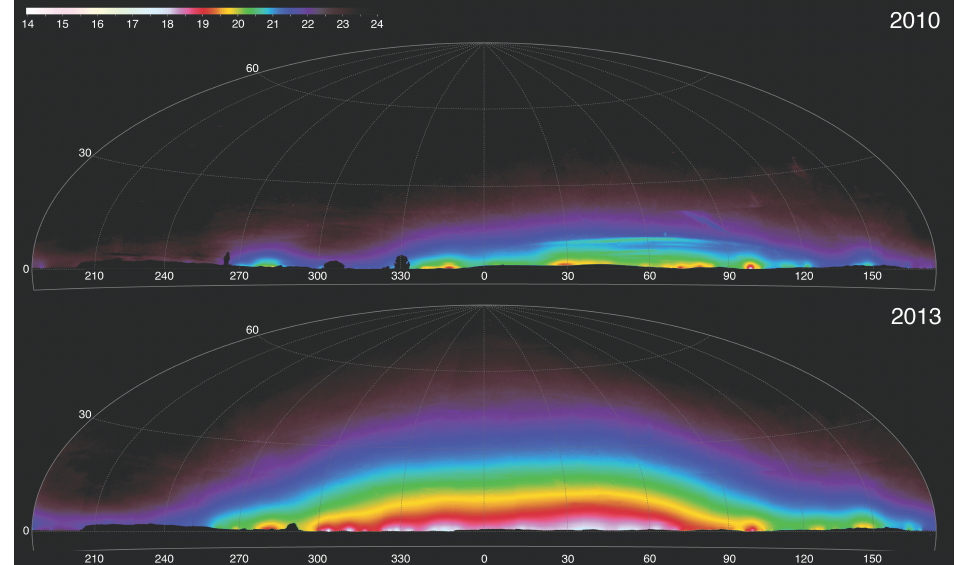
Figure 6. Two views of the modeled anthropogenic component of night sky brightness as seen from Oxbow Overlook in Theodore Roosevelt National Park, U.S., on 1 October 2010 (top) and 9 May 2013 (bottom). These all-sky maps, centered on north (0 ◦ azimuth), are rendered in the Hammer–Aitoff projection with lines of constant altitude and azimuth shown. Calibrated night sky luminance data were obtained using the method described in [109], and a model of the natural sources of light in the night sky according to [106] was subtracted to yield the angular distribution of anthropogenic light. The false colors indicate luminance in units of visual magnitudes per square arcsecond, indicated by the color bar at the upper left. The data were obtained and calibrated by the U.S. National Park Service Natural Sounds and Night Skies